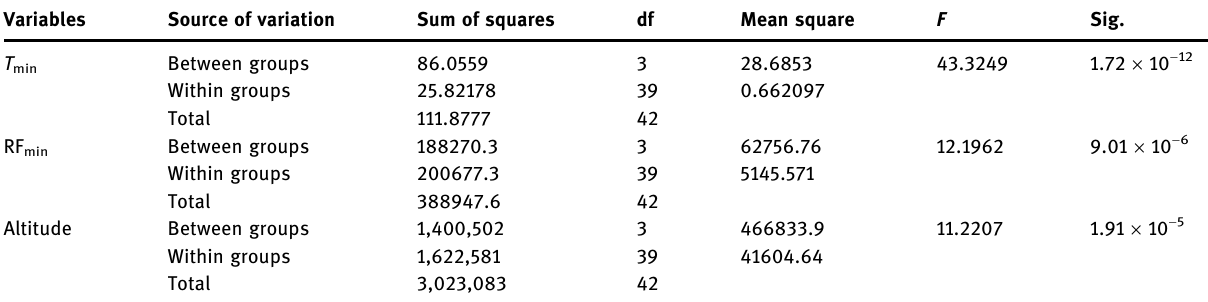
Table 7: ANOVA table for uncorrelated variables of rainfall in FMAM season Variables